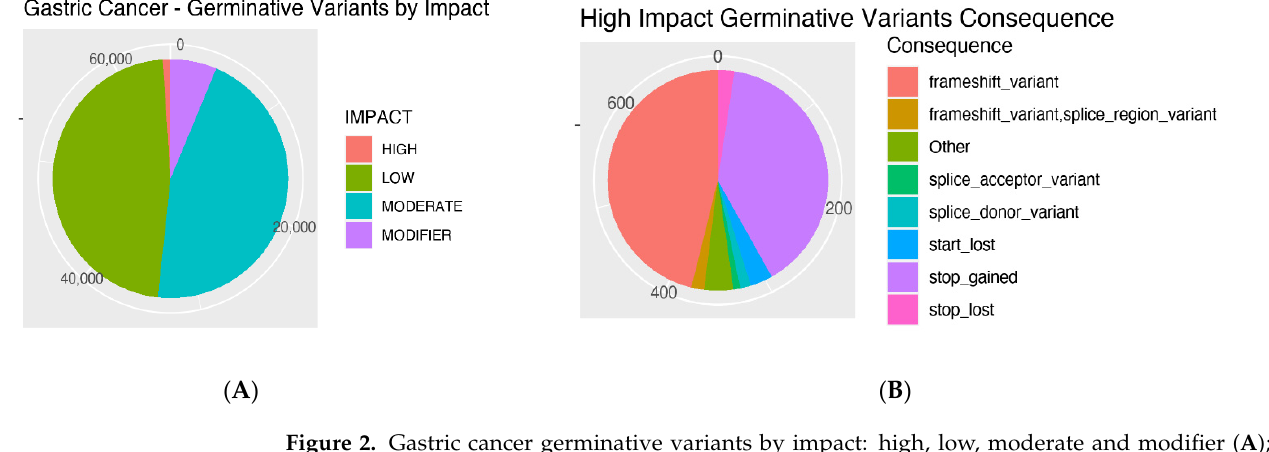
Figure 2. Gastric cancer germinative variants by impact: high, low, moderate and modifier ( A ); Gastric cancer high-impact germinative variants consequence: frameshift, frameshift/splice region, splice acceptor, splice donor, start lost, stop gained, stop lost and others ( B ).